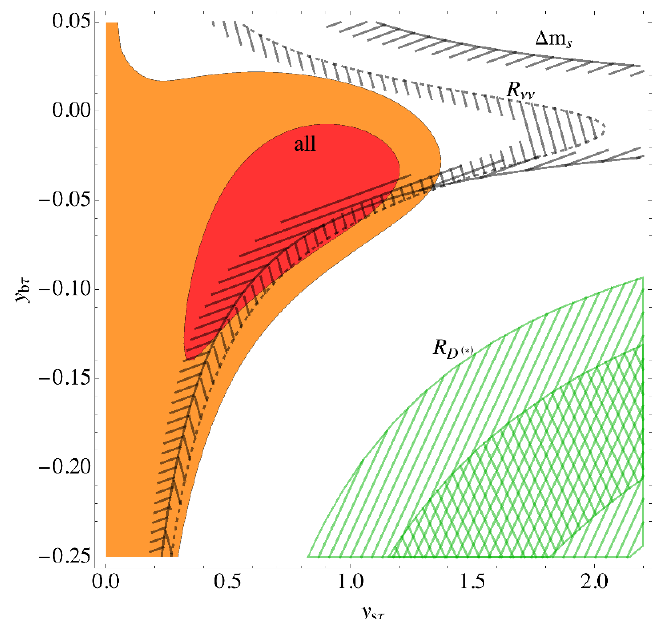
Figure 3 . Fit for the m S 3 = 1 TeV scenario with four free couplings. R D ( (cid:3) ) is resolved within hatched (2 (cid:27) ) and doubly hatched (1 (cid:27) ) regions. Region to the left of the dashed line (hatched) is in 1 (cid:27) agreement with R (cid:23)(cid:23) and R (cid:3) . (cid:1) m s prefers (at 2 (cid:27) ) a region on the hatched side of full line. (cid:23)(cid:23) Red and orange regions are 1 (cid:27) and 2 (cid:27) results of the